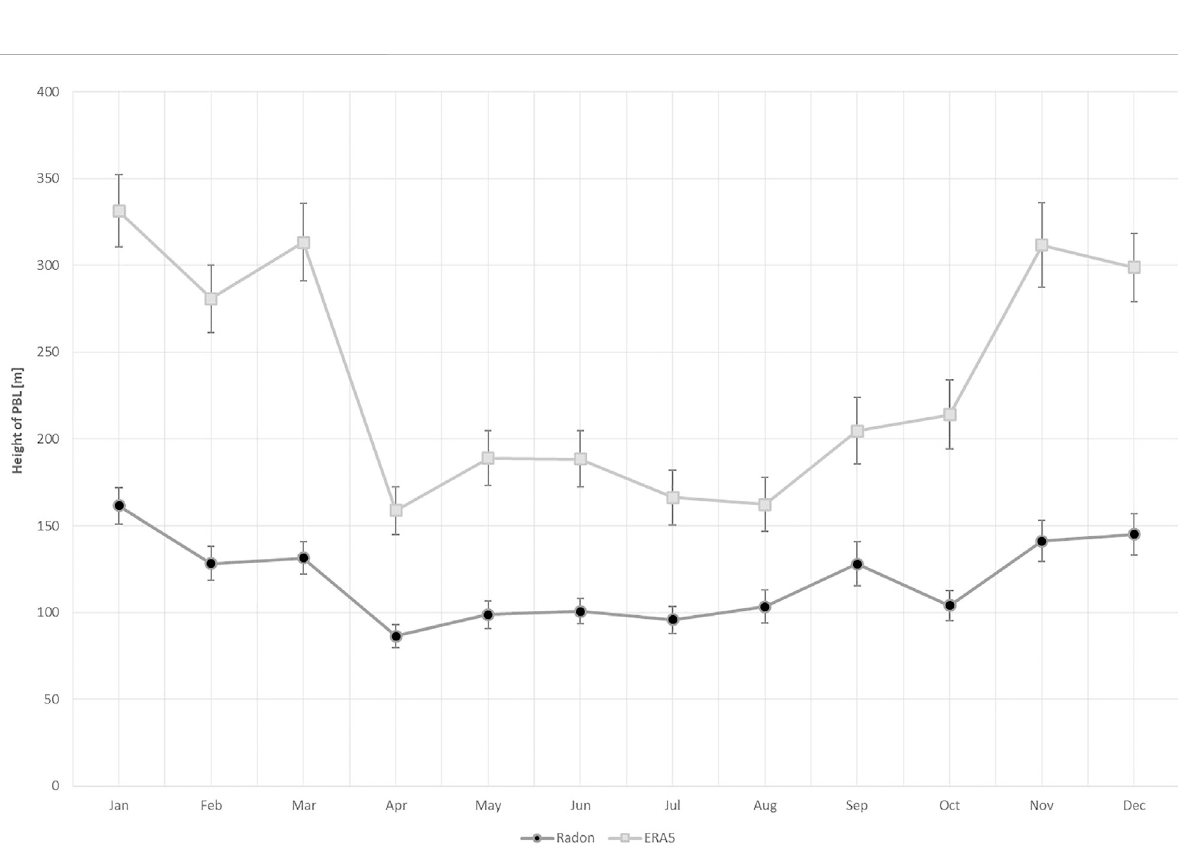
FIGURE 9 MonthlyaveragedNBLheightscalculatedfromradon-basedmethod(circles)andfromtheERA5data(squares)calculatedfromentrydata.Error bars represent a standard deviation (1- σ ) of mean